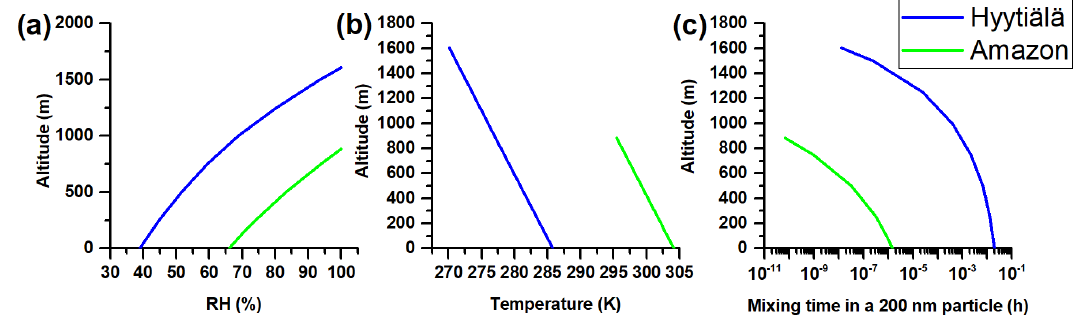
Figure 5. Temperature, RH, and estimated mixing times for α -pinene SOA as a function of altitude for Hyytiälä (boreal forest) and the Amazon (rainforest). The temperature and RH at ground level are the average afternoon values in the driest month of the year for the respective locations. The vertical profiles of temperature and RH are plotted until the RH is 100% for these locations. The height at which RH reaches 100% is only slightly lower than the average height of the planetary boundary layer predicted by GEOS-5 meteorology data. For details see the Supplement, Sect. S1. The viscosity parameterization used to calculate mixing times was based on α -pinene SOA generated using mass concentrations of ∼ 1000µgm − 3